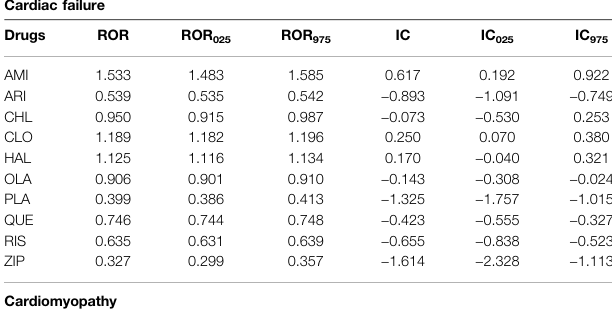
TABLE 2 | The association of cardiotoxicities with antipsychotics. Cardiac failure